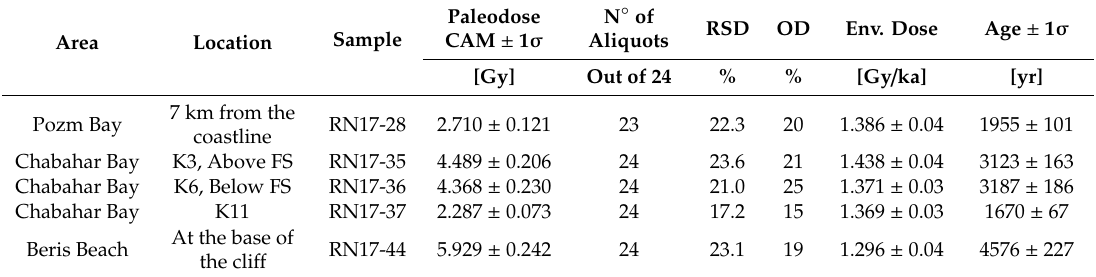
Table2. ResultsofOSL dating. Geolocalisation andmore analyticaldetailsareinthedata repository[56].